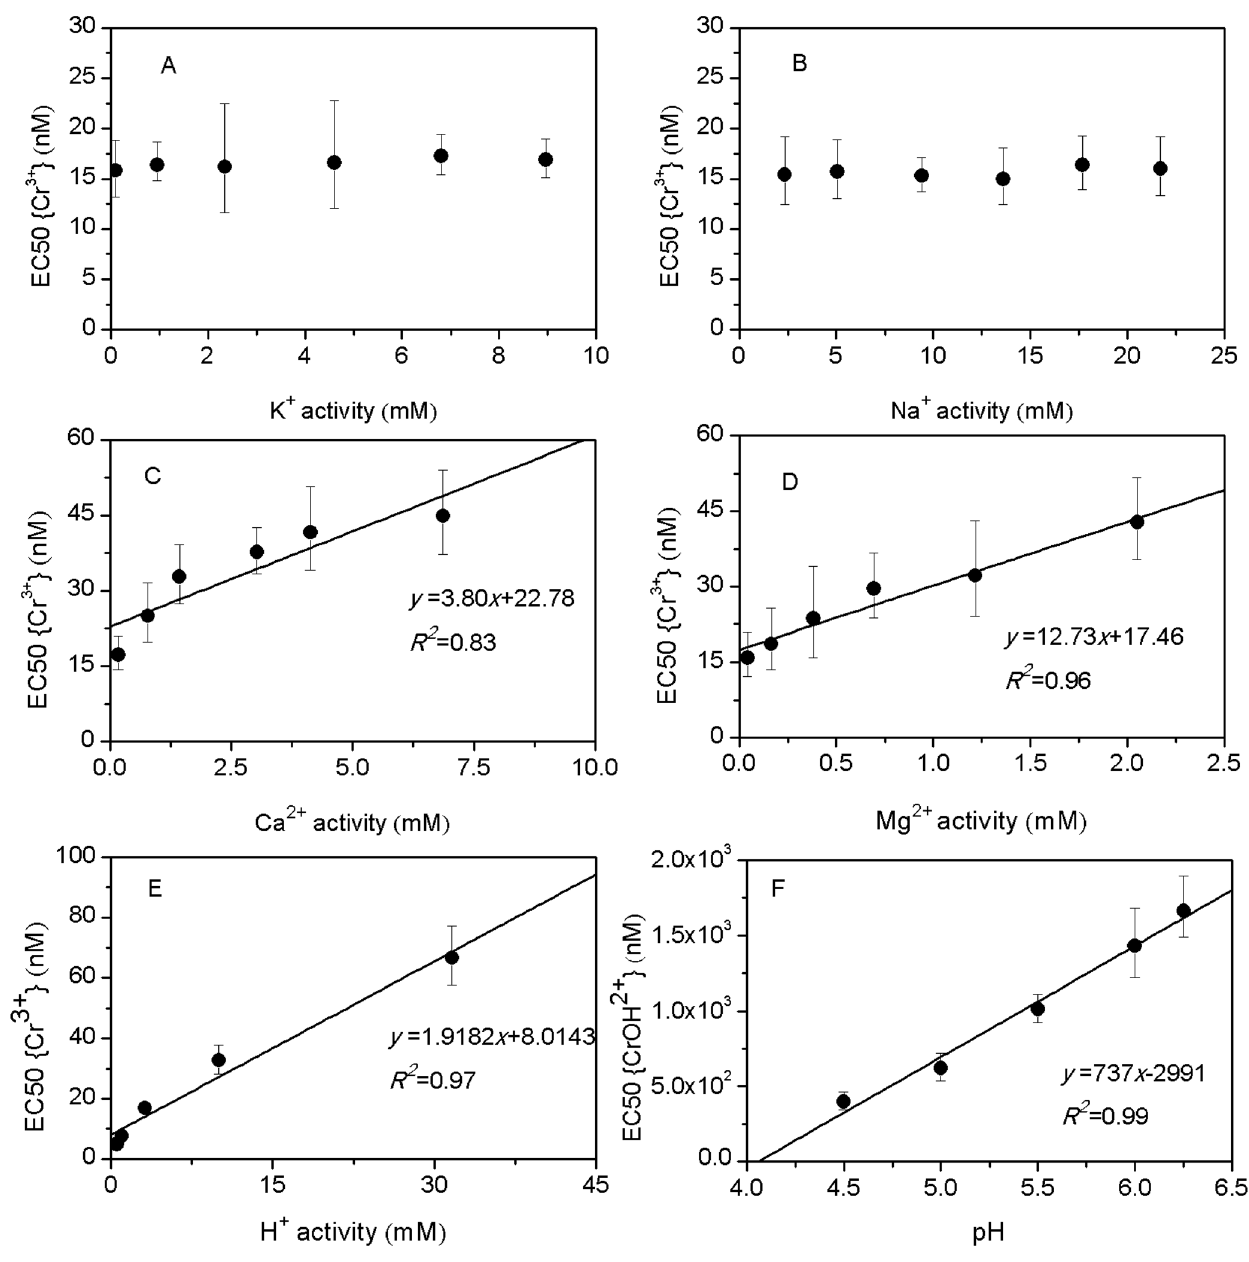
Figure 2. The EC50 values expressed as free Cr 3 + activity (EC50{Cr 3 + }) for (A, B, C, D, E) or free CrOH 2 + activity (EC50{CrOH 2 + }) (F) for barley root elongation as a function of the free activity of K + (A), Na + (B), Ca 2 + (C), Mg 2 + (D), H + (E), and pH (F). Error bars indicate 95% confidence intervals. Solid lines represent significant correlations.